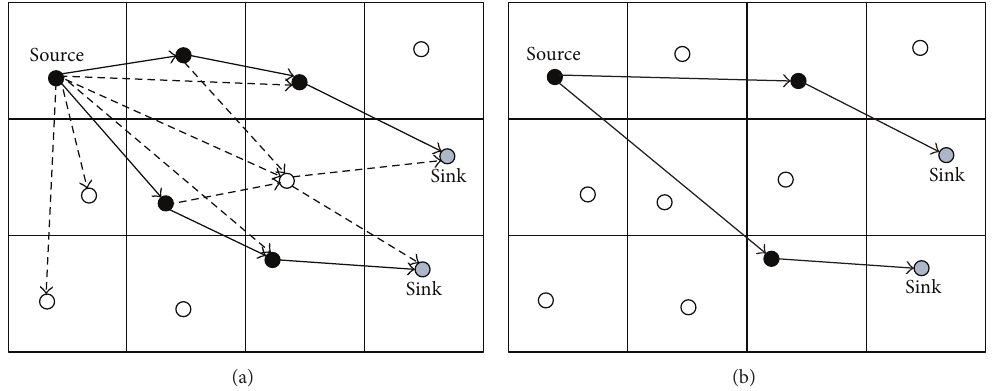
Figure 5: Comparison of the routing scheme between DGAF and T-DGAF (a) In DGAF, a sensor can forward the data packet to any sensors of its AGs, while (b) In T-DGAF, a sensor can forward the data packet to any sensors of its NAGs, if they are in the transmission